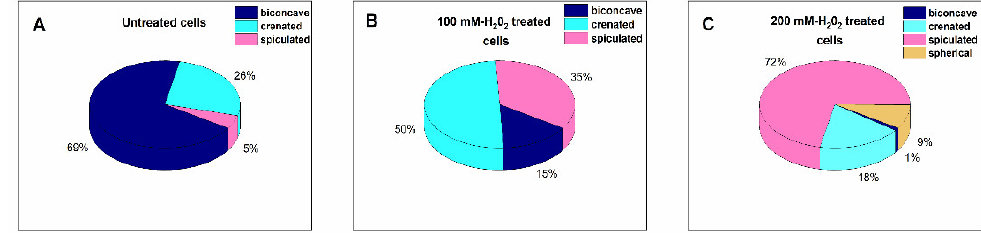
Figure 7. Erythrocytes’ morphology classes obtained by means of optical microscopy determined for newly isolated untreated cells from healthy controls ( A ) and cells subjected to 100 mM ( B ) and